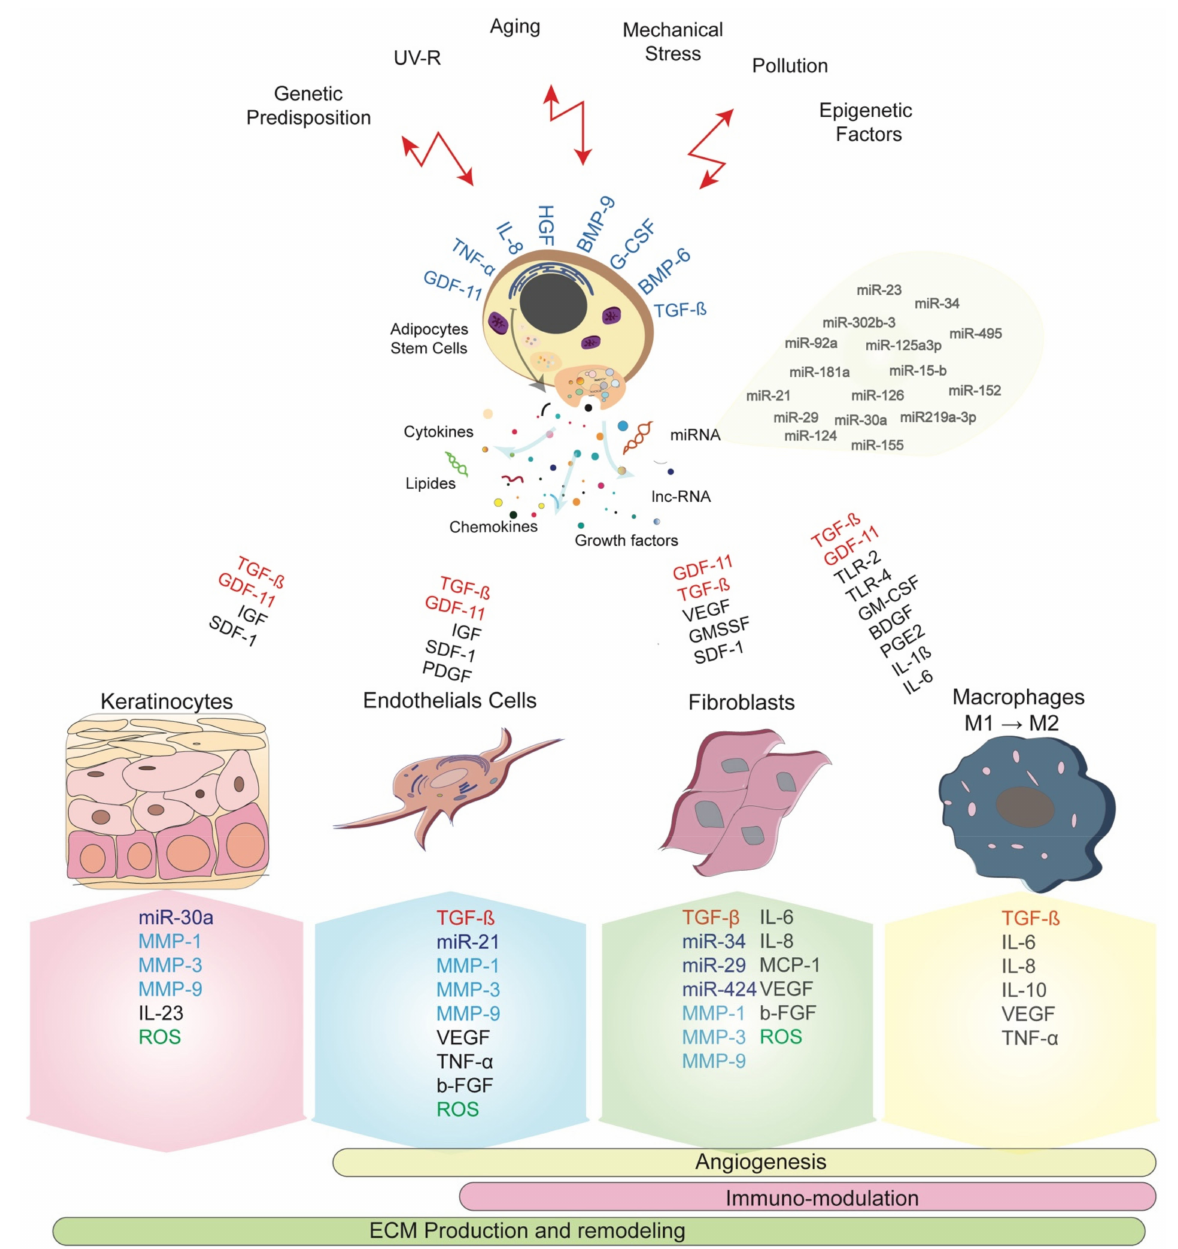
Figure 1. ADSCs within their network and exosomes-derived biomolecules involved in the different biological processes associated to skin aging and regeneration. ADSCs microenvironment is impacted by their cellular network and is closely dependent of its enrichment of skin and immune cells and their ability to secrete adequate and sustainable quantities of growth factors, cytokines, miRNAs and other transcriptional factors. Specific biomarkers are identified and might serve as new parameters for skin immunomodulation during skin regeneration and aging